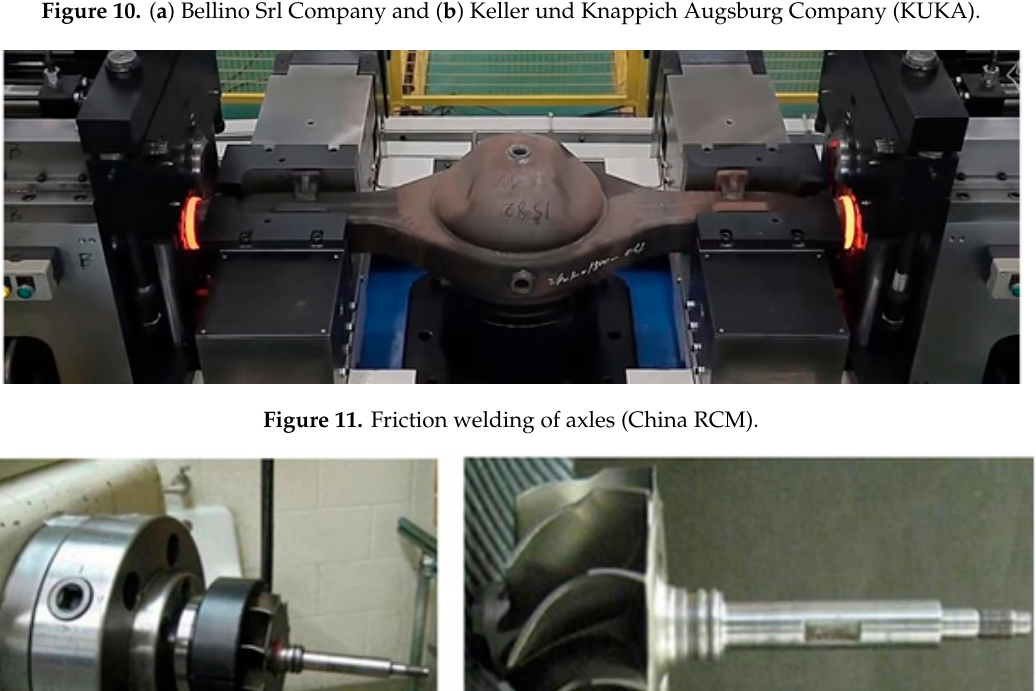
Figure 10. ( a ) Bellino Srl Company and ( b ) Keller und Knappich Augsburg Company (KUKA).